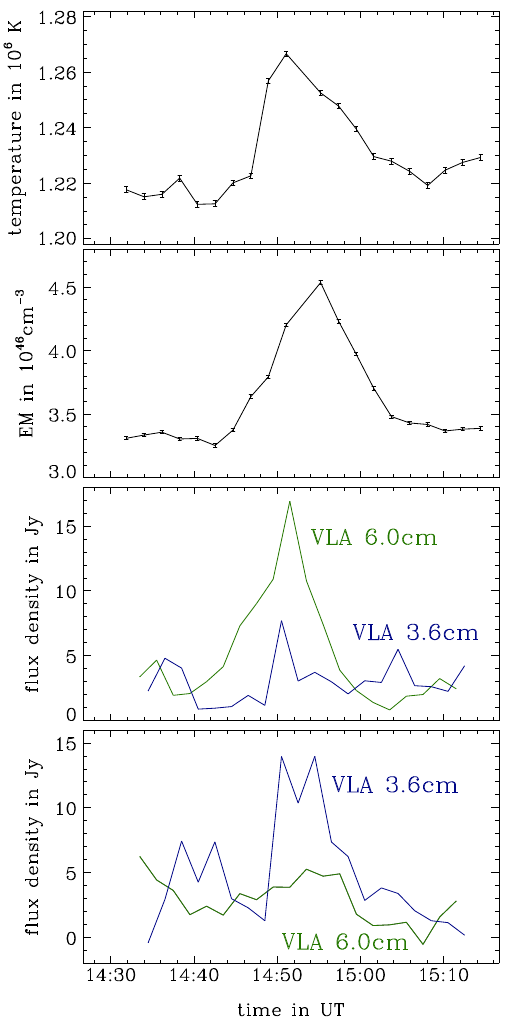
Fig. 27 Time profile of quiet-region microflare observed in Fe xi / x , and Fe xii lines at 17.1 nm and 19.5 nm by EIT/SOHO. Top panel temperature averaged over the area of the event; second panel the emission measure; third panel radio flux observed by the VLA at 6 and 3.6 cm wavelength at the location of the 6 cm peak; bottom panel same at the location of the 3.6 cm peak (after Krucker and Benz